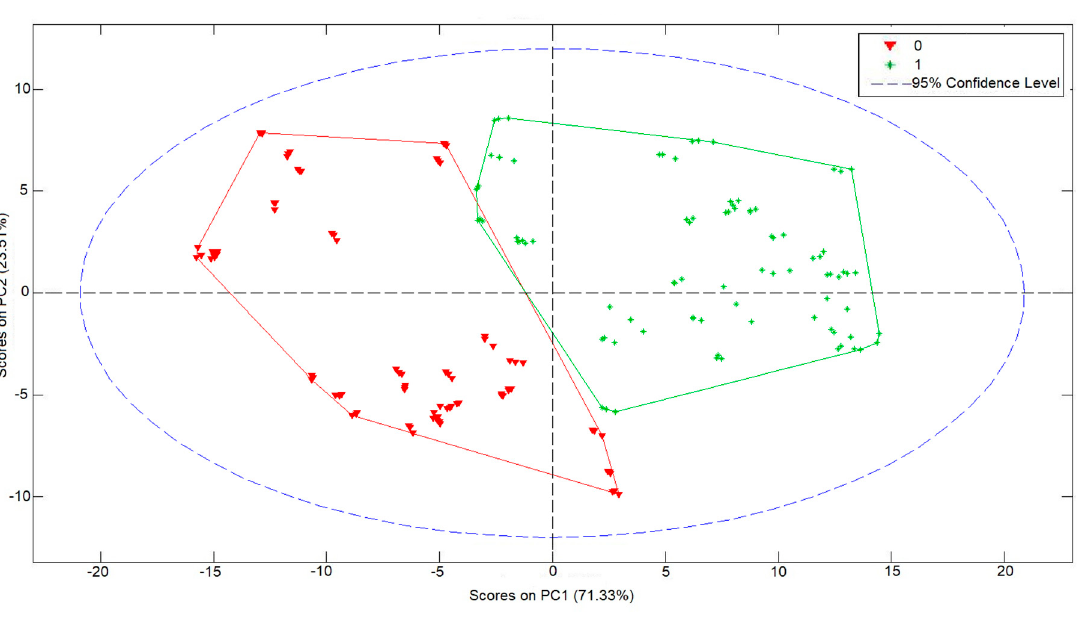
Figure 5. Principal components analysis (PCA) for the studied lemons considering data between two sections. Class 0 (red) represents frozen samples. Class 1 (green) represents the natural ones.